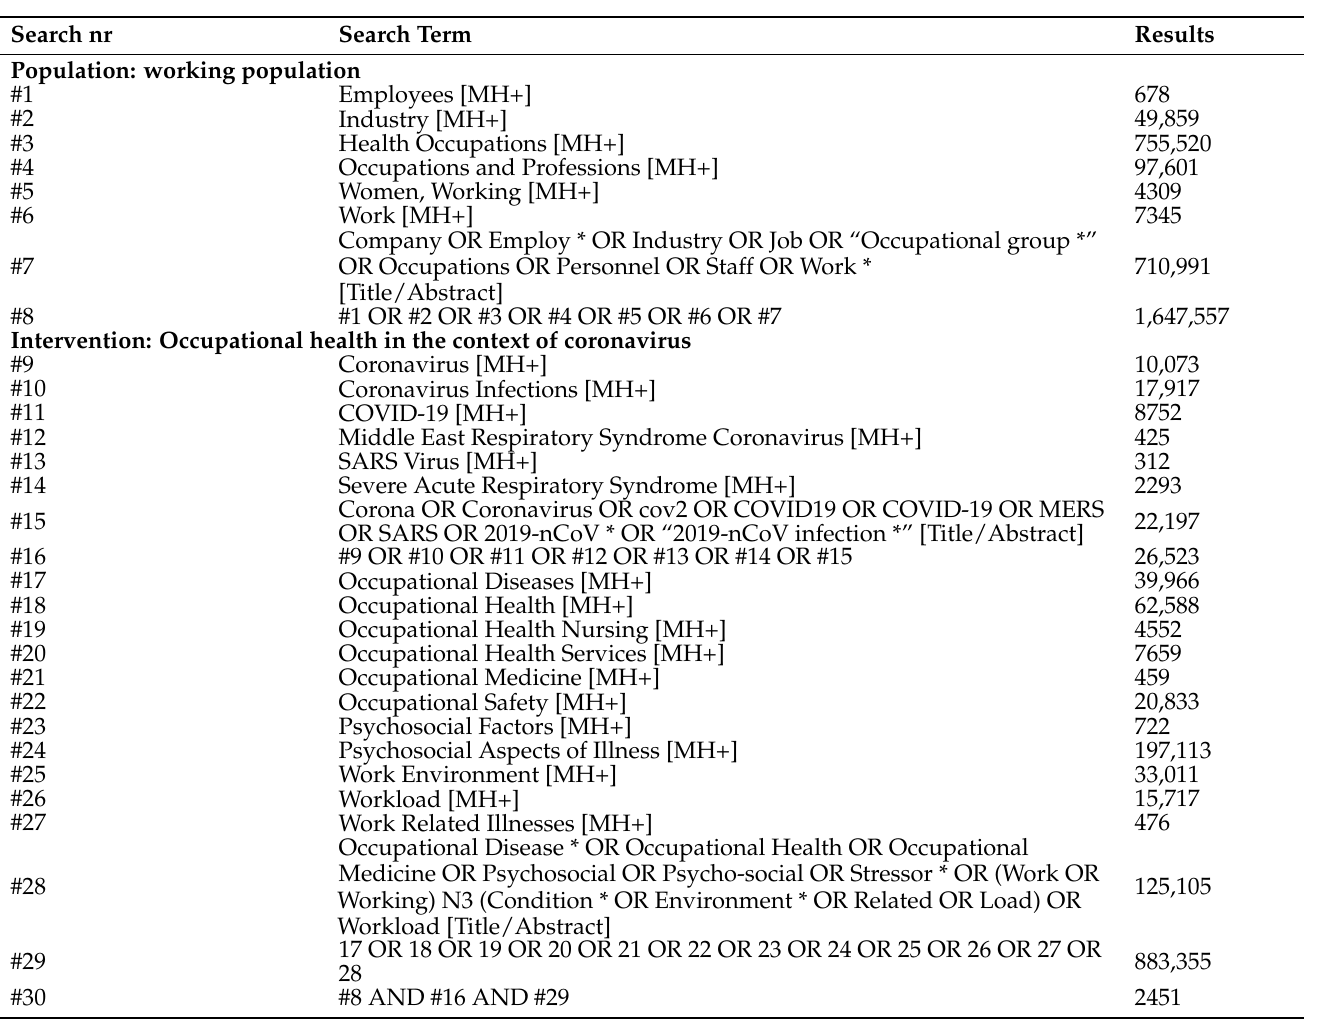
Table A1. Database: Cinahl (via Ebsco) Date: 5 October